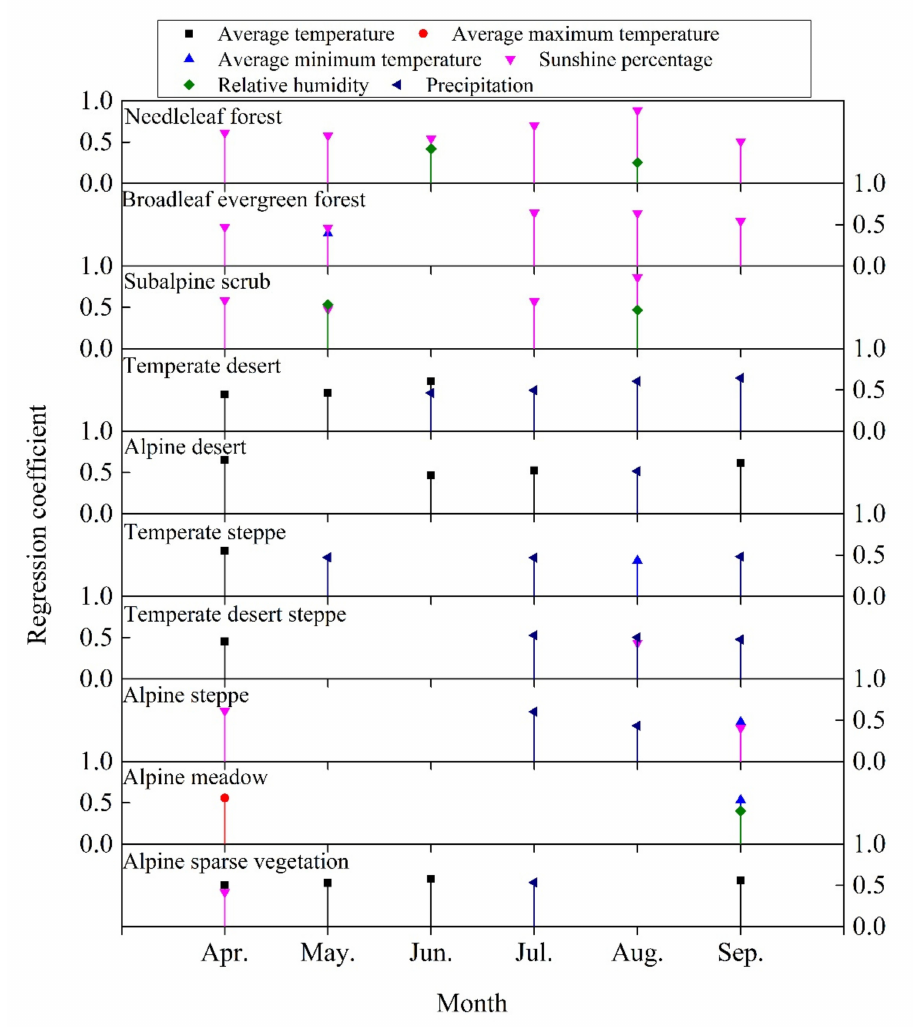
Figure 10. Selected climatic variables and regression coefficients of these variables to the NDVI of each vegetation type in each month during the growing season (April to September). Note that there is no significant influencing variable in some growing stages of some vegetation